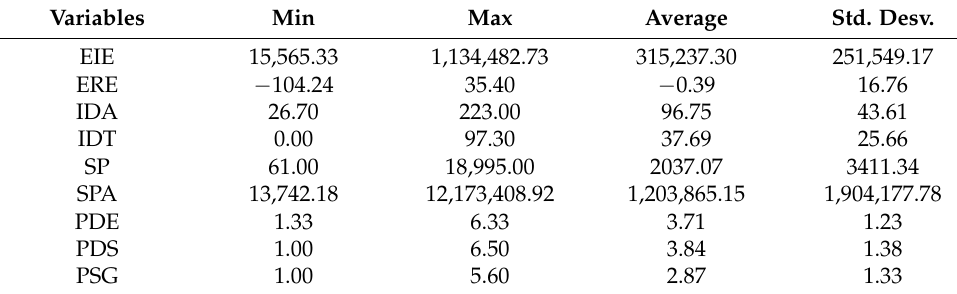
Table 3. Descriptive statistics of the variables under study.